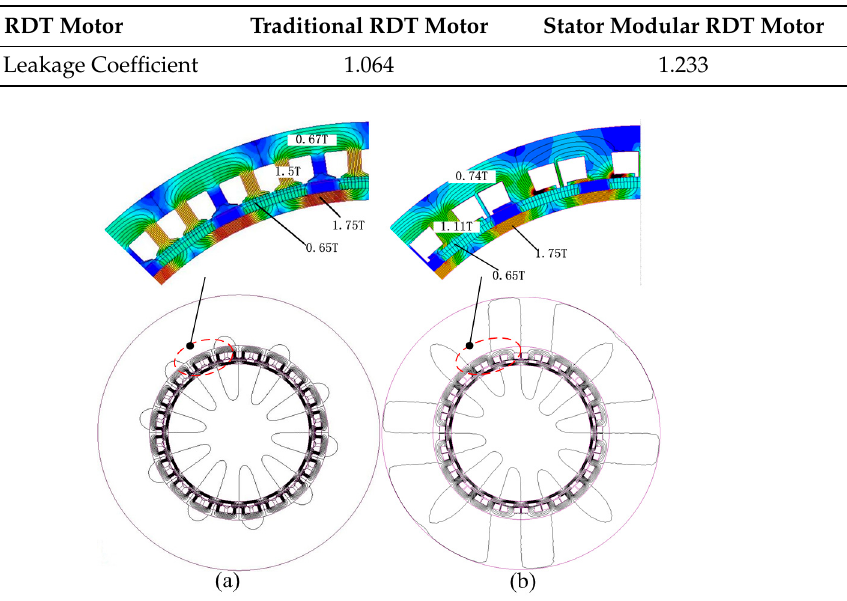
Figure 7. Static magnetic field distribution ( a ) Traditional RDT motor ( b ) Stator modular RDT